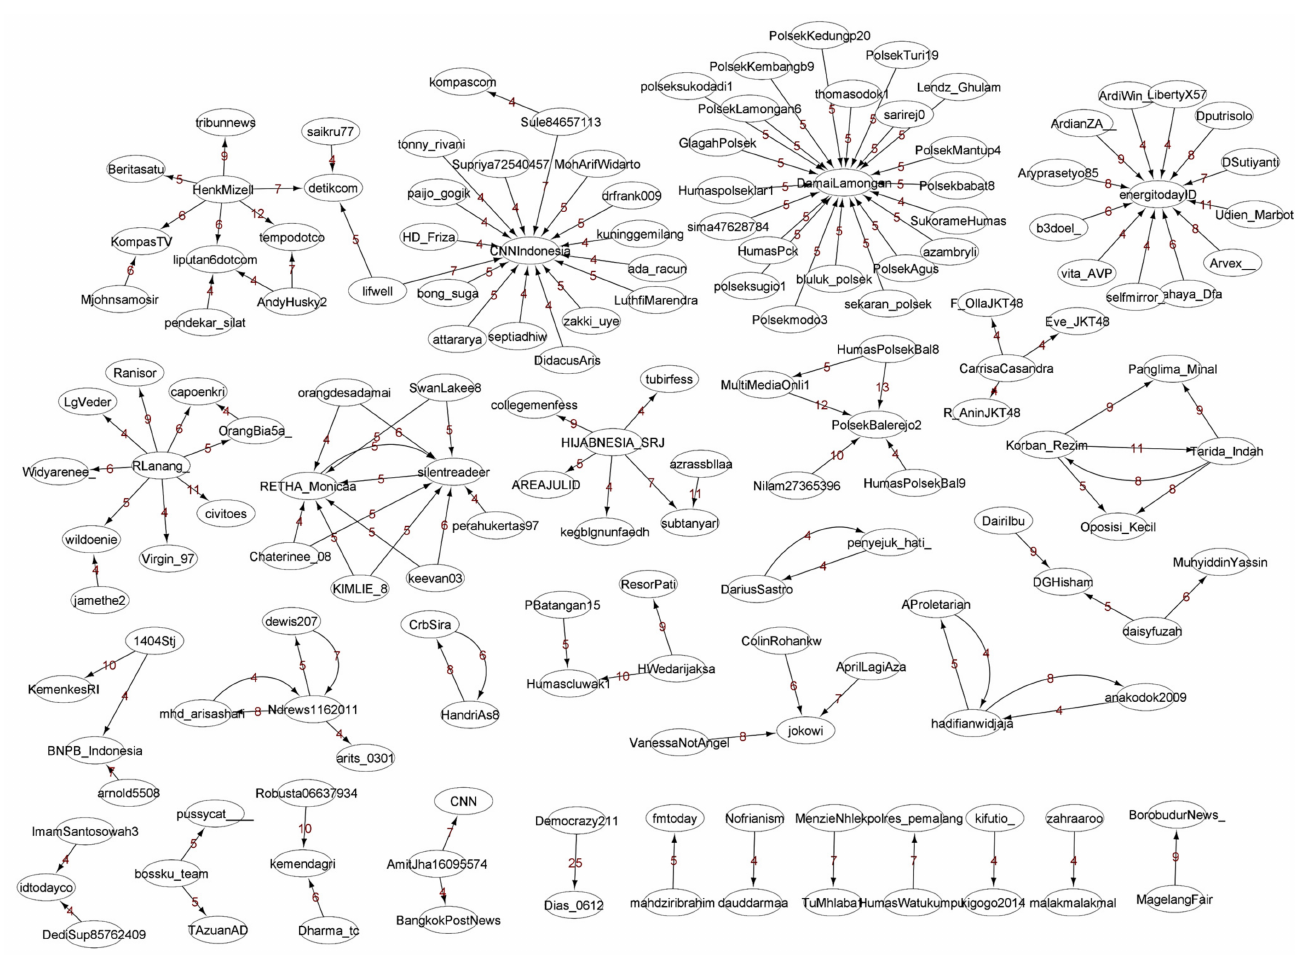
Figure 8. Some part of the clean and filtered-weighted-directed graph,